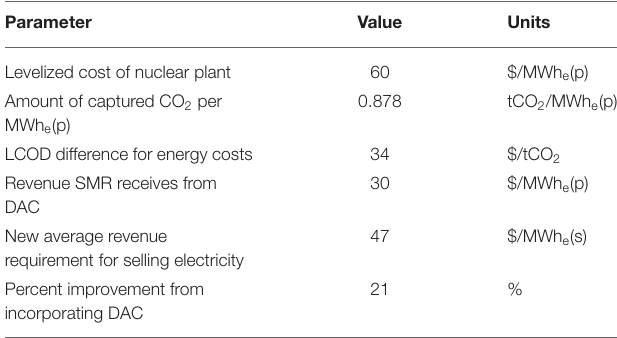
TABLE 4 | Cost analysis for nuclear SMR and DAC